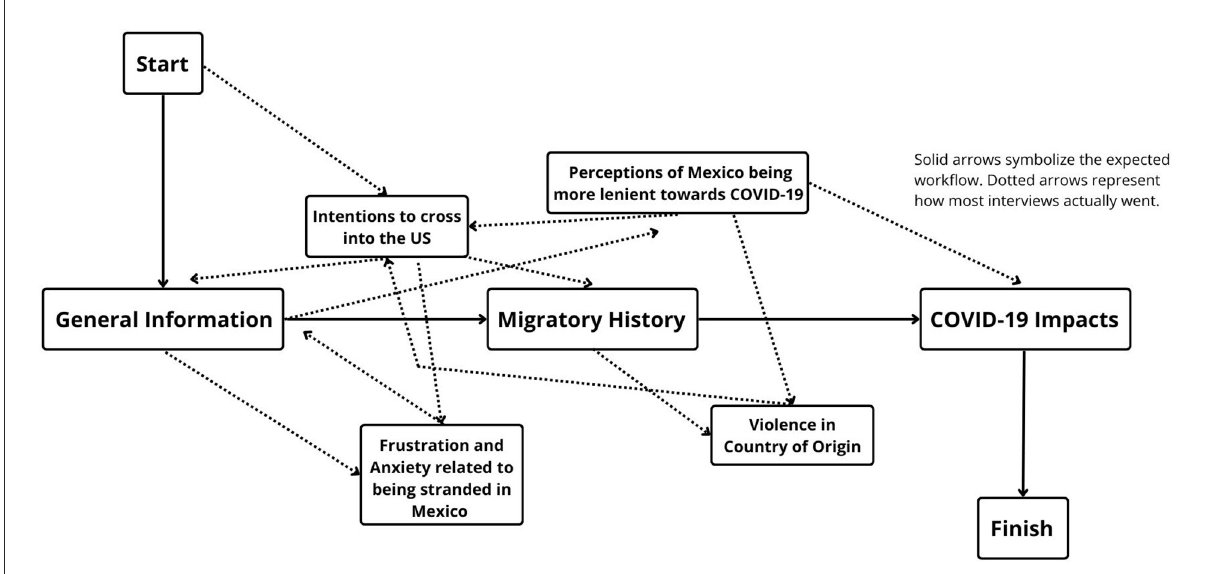
FIGURE1 Narrative workflow during each interview. Solid arrows symbolize the expected workflow. Dotted arrows represent how most interviews actually went (Source: COVID-19 differential Impact on Indigenous and Newcomers: A socioeconomic analysis of Canada, US and Mexico, 2021).